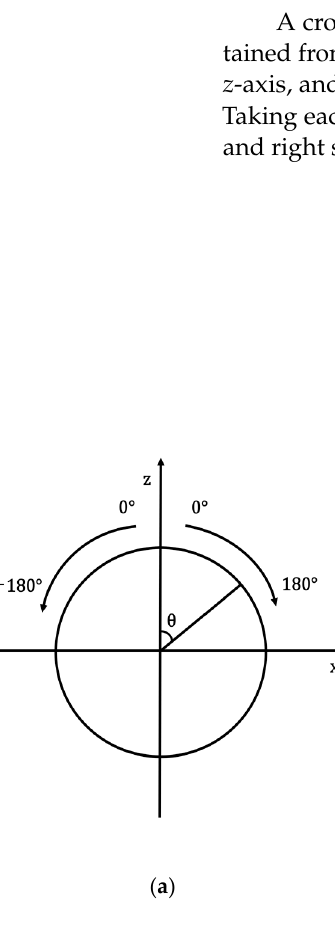
Figure 4. ( a ) Tunnel projection and ( b ) tunnel wall expansion effect. Table 1. Post-projection data structure.